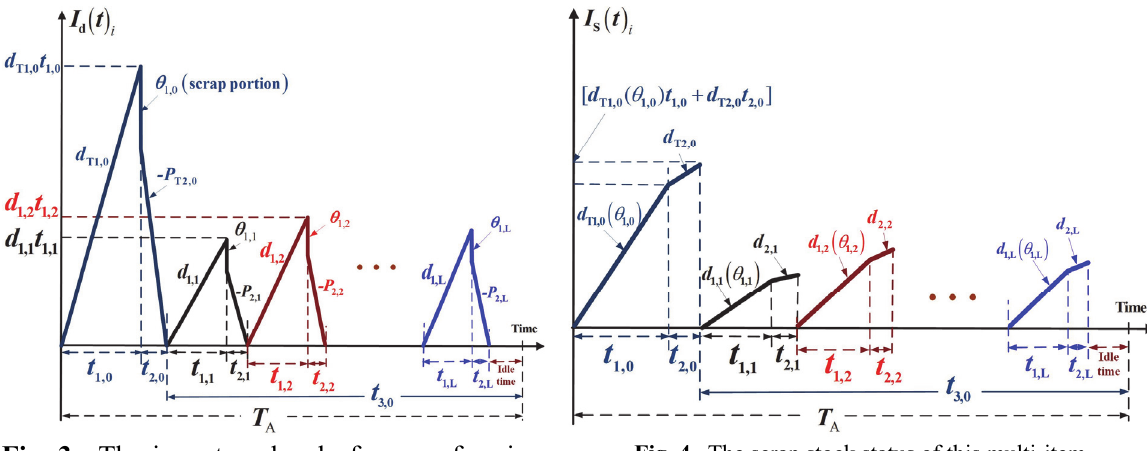
Fig. 3. The inventory level of nonconforming items of this multi-item postponement model